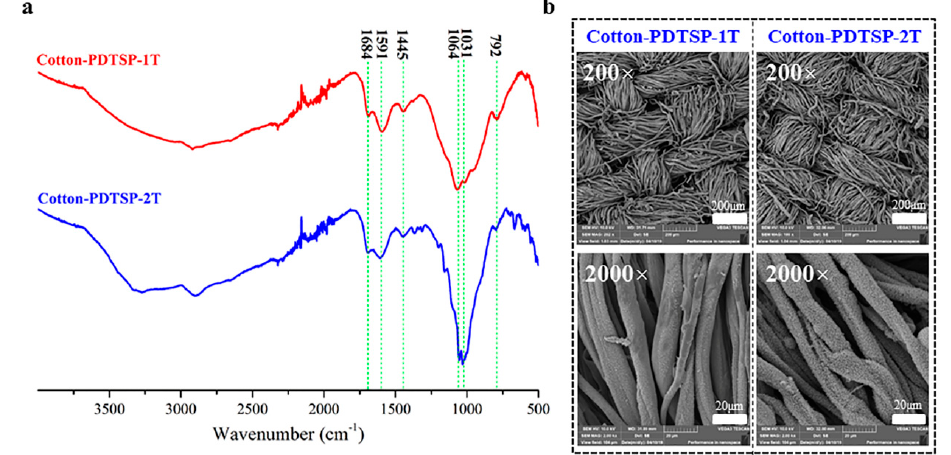
Figure 4. FT-IR spectra ( a ) and SEM ( b ) of char residues for PDTSP coated cotton fabrics. SEM photos with di ff erent magnification of PDTSP-coated fabrics after VFT were given